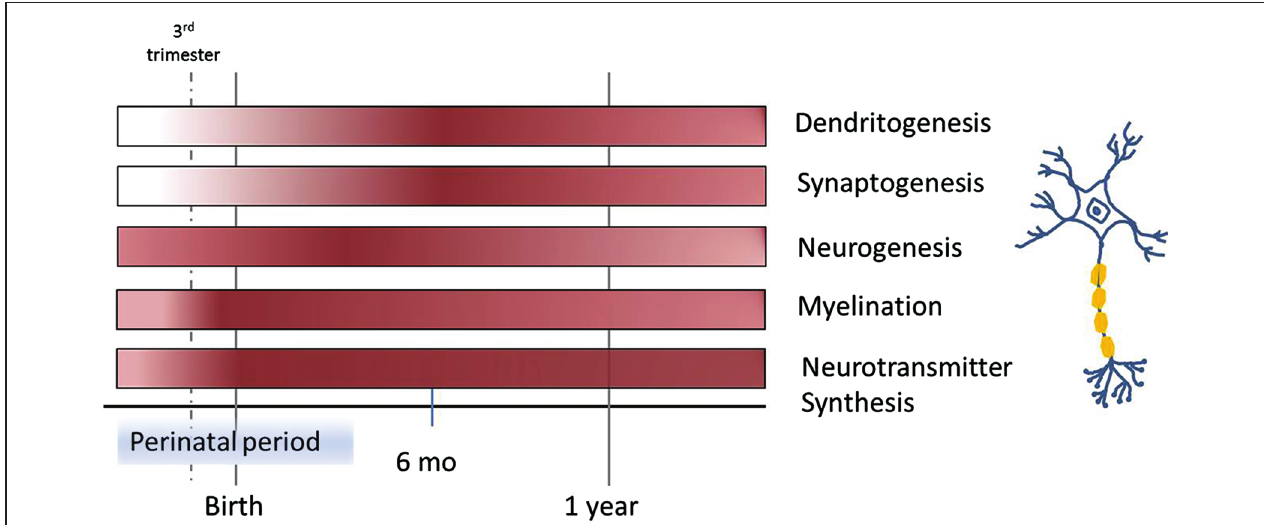
FIGURE 1 | Time course of different processes in brain development involved in learning and memory over the first year of life, highlighting periods of vulnerability to iron deficiency . Color intensity corresponds with the start, as well as peaks within each